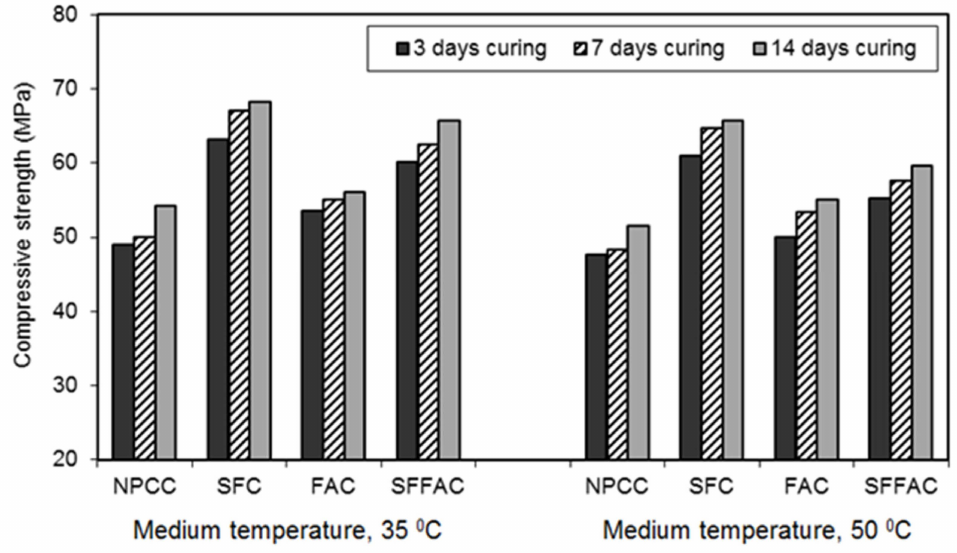
Figure 3. The 28-day compressive strength of different types of concrete transferred after 3, 7 and